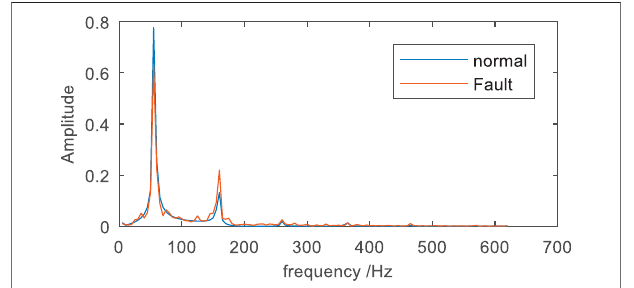
FIGURE 6 | Spectrum diagram under Fourier